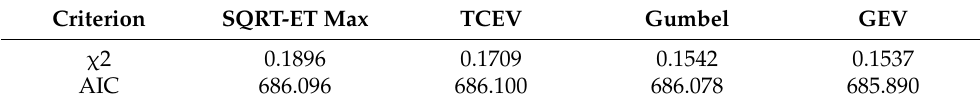
Table 4. Goodness-of-fit test statistics.